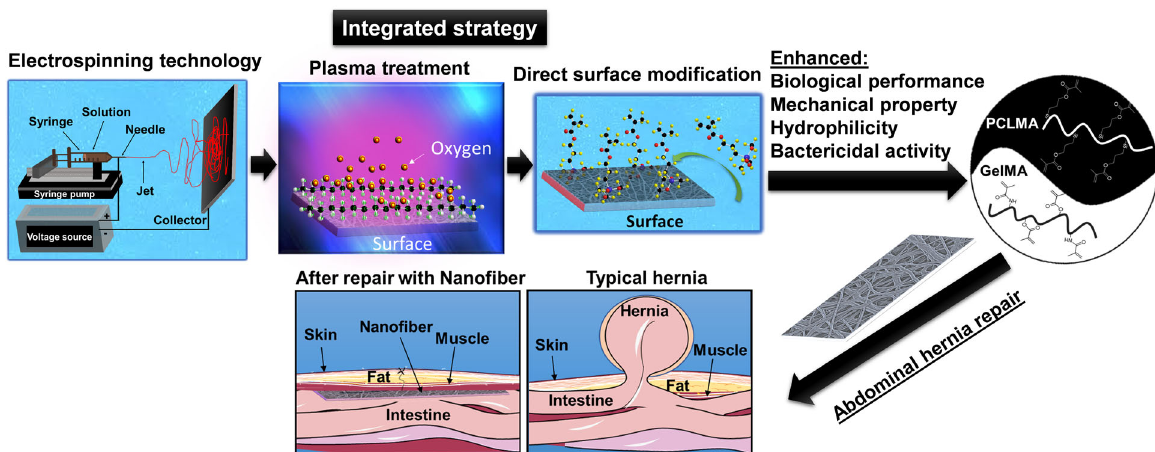
Fig. 1 An overview of the integrated engineering strategy. The approach comprises an integrated strategy for the design of an innovative polycaprolactone (PCL)-based nano fi ber by combining a facile and low-cost electrospinning technology (ES) with plasma treatment (PT) and direct surface modi fi cation (DSM) (ES-PL-DSM) approach providing PCL methacrylate (PCLMA) nano fi bers with improved properties (such as hydrophilicity, mechanical properties, bactericidal property, and biological performance). The biological performance can be further improved through the incorporation of gelatin methacryloyl (GelMA). The engineered nano fi bers could function as a good candidate for abdominal hernia